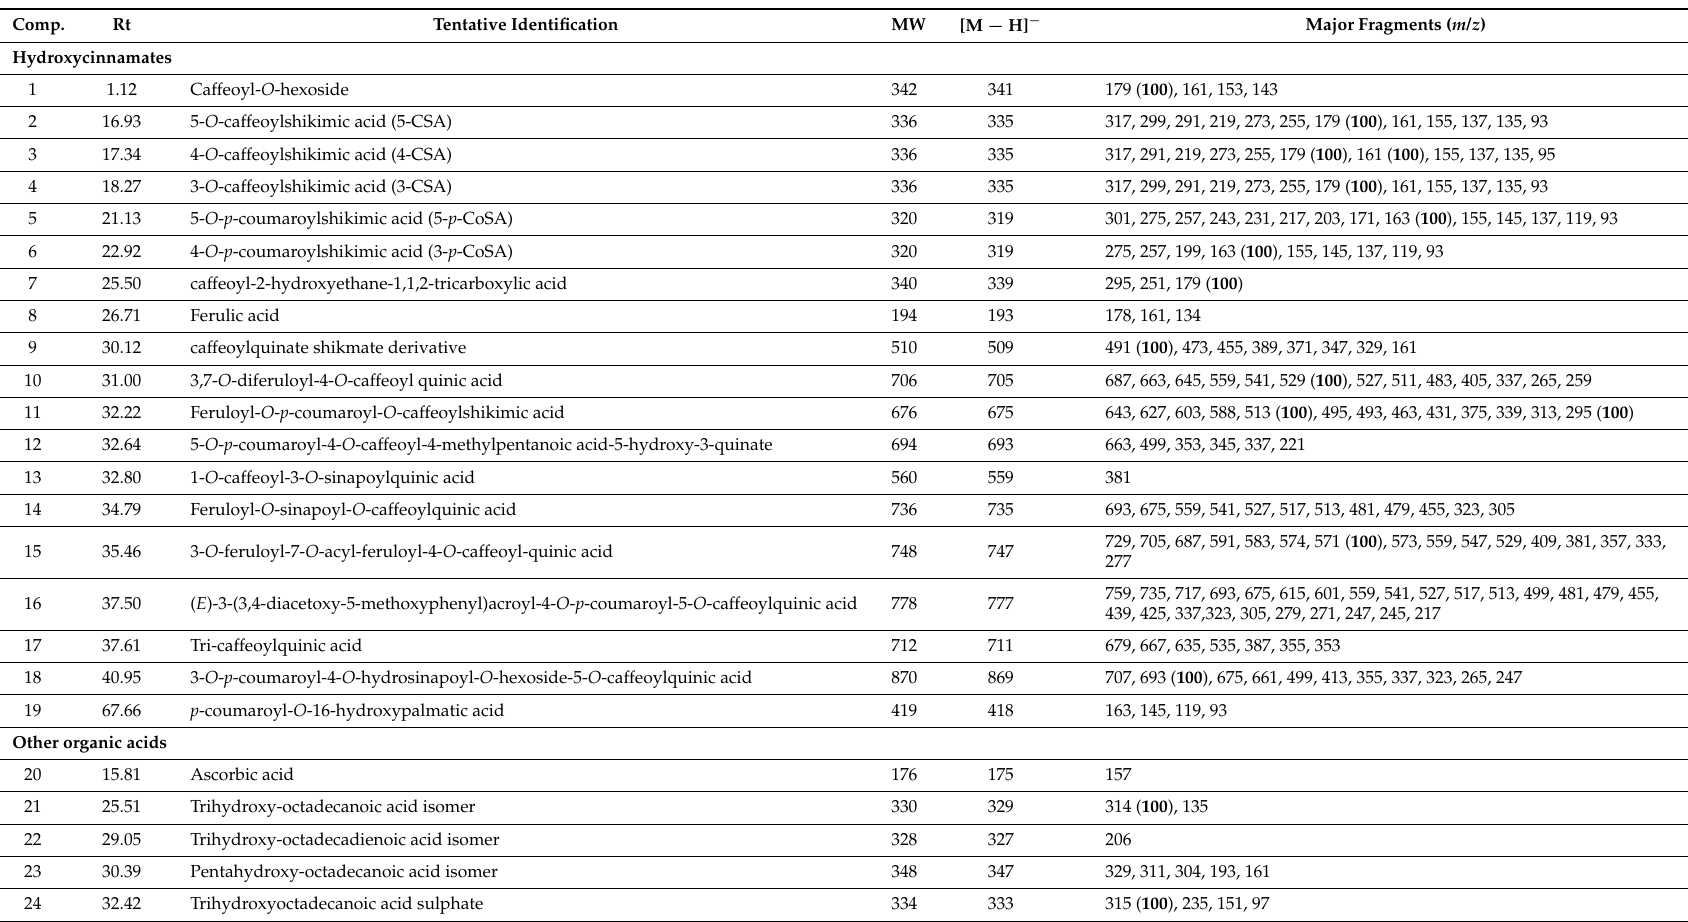
Table 1. Characterization of polyphenolic compounds in male flowers of date palm using LCESI-MS/MS in negative ion